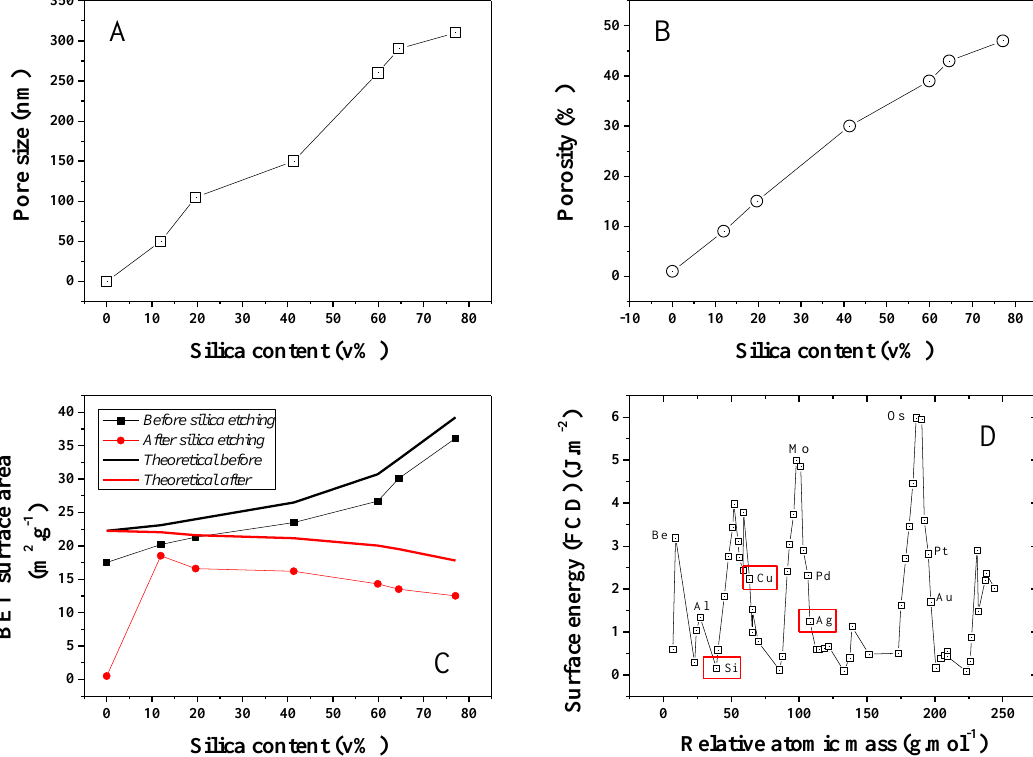
Figure 7. ( A ) Average pore size distribution obtained for the series of Ag-Si nano-composites after Si etching; ( B ) Average porosity for the same series; ( C ) BET surface area for the series of samples before and after etching and theoretical BET surface area calculated for an estimated individual surface area of the Si and Ag NP powders of 23.81 and 30 m 2 ·g −1